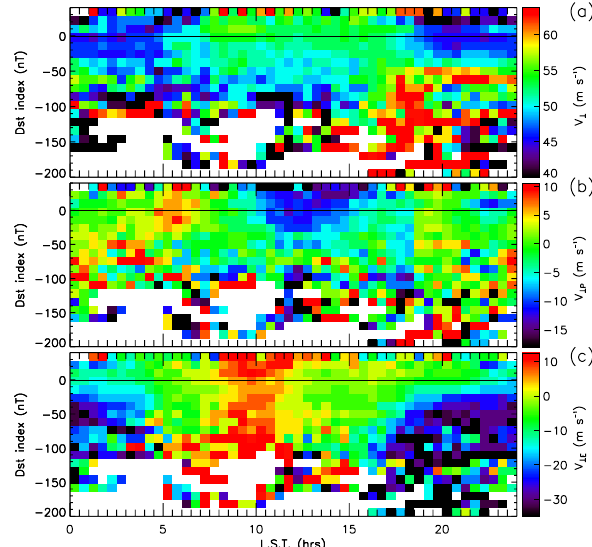
Fig. 4. Colour map showing the variation of (a) velocity magnitudes V ⊥ , (b) V ⊥ P , and (c) V ⊥ E with LST and AE index for the entire 5-year database. The velocities were averaged using bin sizes of 20-min in LST and 50nT in AE index.